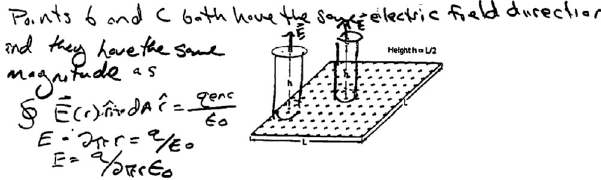
FIG. 2. A sample response from a student for the post-test question (4).